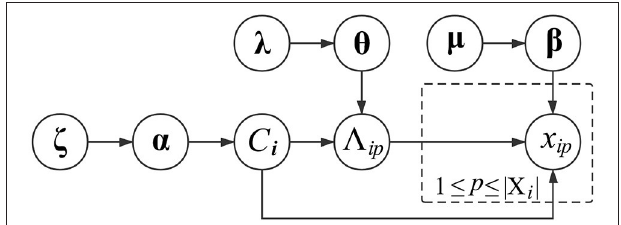
FIGURE 1 | Graphical model representation of generating the GO information of proteins.